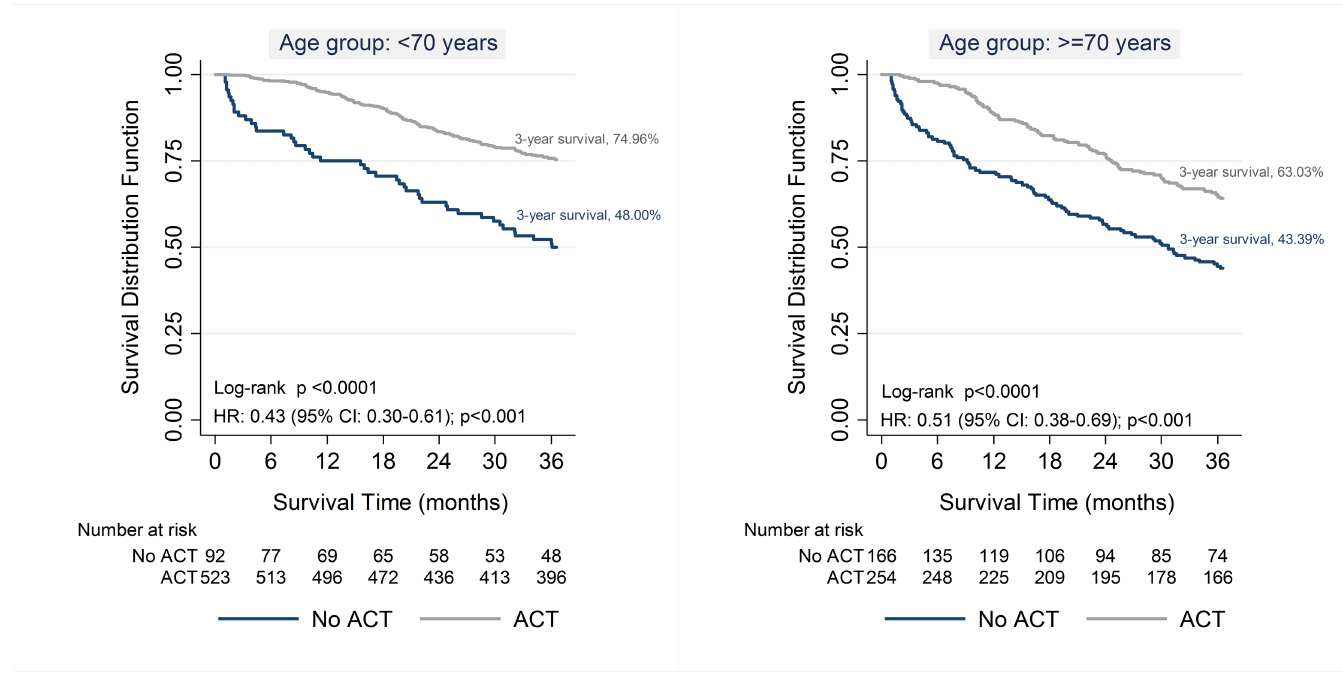
Fig 1. Three-year overall survival according to the Receipt of ACT stratified by age group ( < 70 years and (cid:21) 70 years) ACT = adjuvant chemotherapy.